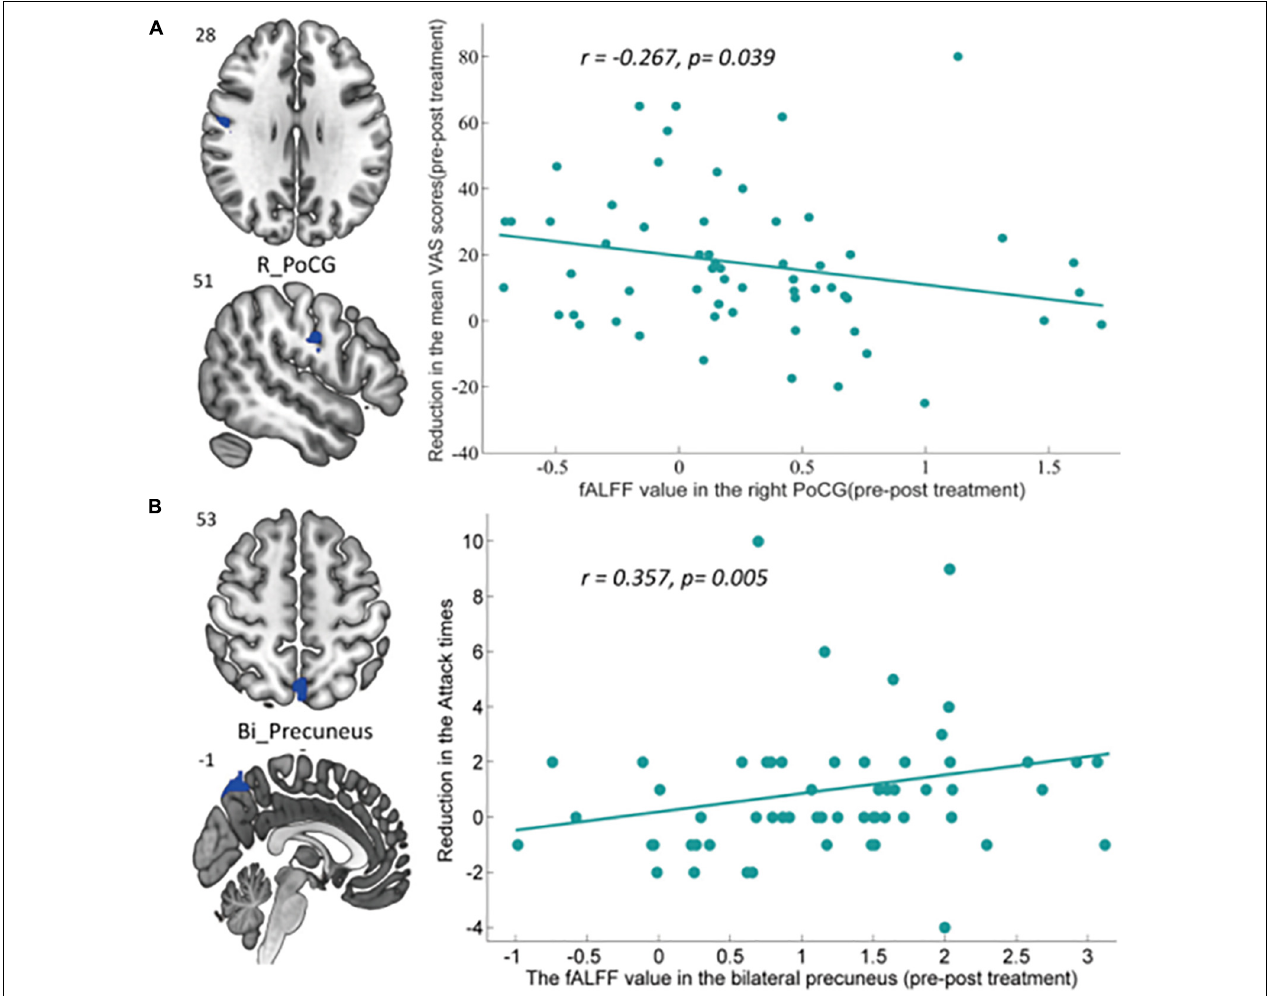
FIGURE 6 | Significant correlation between the altered intragroup fALFF and clinical outcomes. (A) Correlation between the altered fALFF in the right PoCG (pre–posttreatment) and the reduction of VAS scores. The decreased fALFF in the right PoCG after 4-week taVNS treatment was negatively associated with corresponding reduction of VAS scores in MWoA patients ( r = –0.267, p = 0.039, uncorrected). (B) Correlation between the altered fALFF in the bilateral precuneus (pre–posttreatment) and the reduction of migraine attack times. The decreased fALFF in bilateral precuneus after 4-week taVNS treatment was positively associated with the reduction of attack times ( r = 0.357, p = 0.005, Bonferroni correction, 0.05/5). Bi, bilateral; L, left; PoCG, postcentral